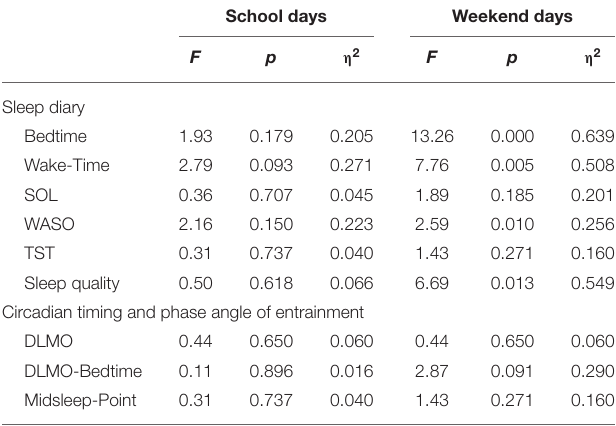
FIGURE 2 | Scatter plots of phase angle relative to TST. Regressions are computed separately for school nights (solid line) and weekend nights (dashed line). Larger interval (phase angle) between circadian phase and bed time is related to longer sleep duration on weekend nights ( r = − 0.716, p = 0.001), but not on school nights ( r = − 0.436, p = 0.080). A wider phase angle of entrainment between DLMO phase and bedtime has been shown to be associated with a shorter intrinsic circadian period (tau), and reduced sleep need. TABLE 2 | Overview of inferential statistics for group (slight vs. moderate vs. extreme late type) ( N = 18). School